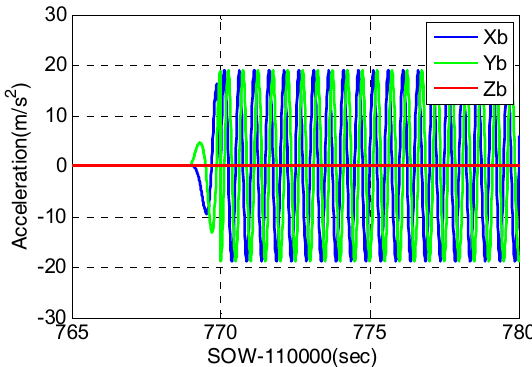
Figure 10. Recorded accelerometer raw data in signal simulator tests.